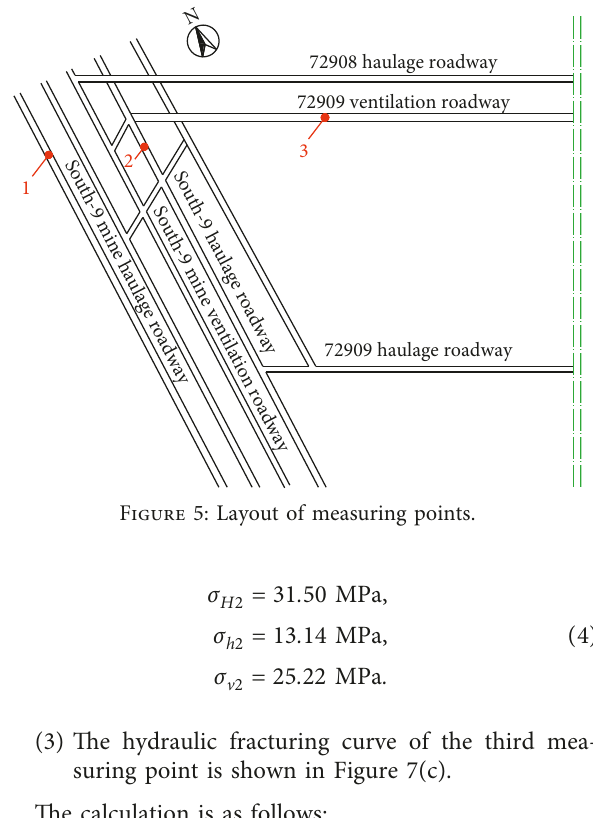
Figure 5: Layout of measuring